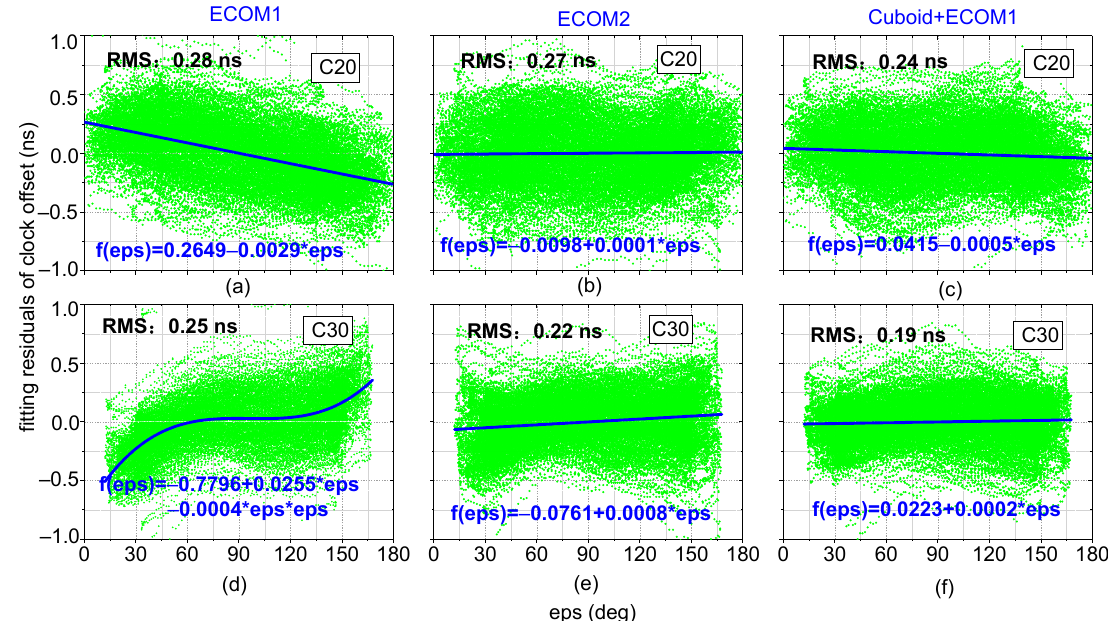
Figure 8. Residuals of the satellite clock offset, fitted by the quadratic polynomial. ( a ) and ( d ) are the ECOM1 results of C30 and C20, ( b ) and ( e ) are the ECOM2 results of C30 and C20, and ( c ) and ( f ) are the Cuboid + ECOM1 results of C30 and C20, respectively. The blue line is the cubic polynomial fitting curve of the residuals. Table 8. RMS of the clock offset residuals, fitted by a quadratic polynomial for a 3-day arc. The unit is ns.